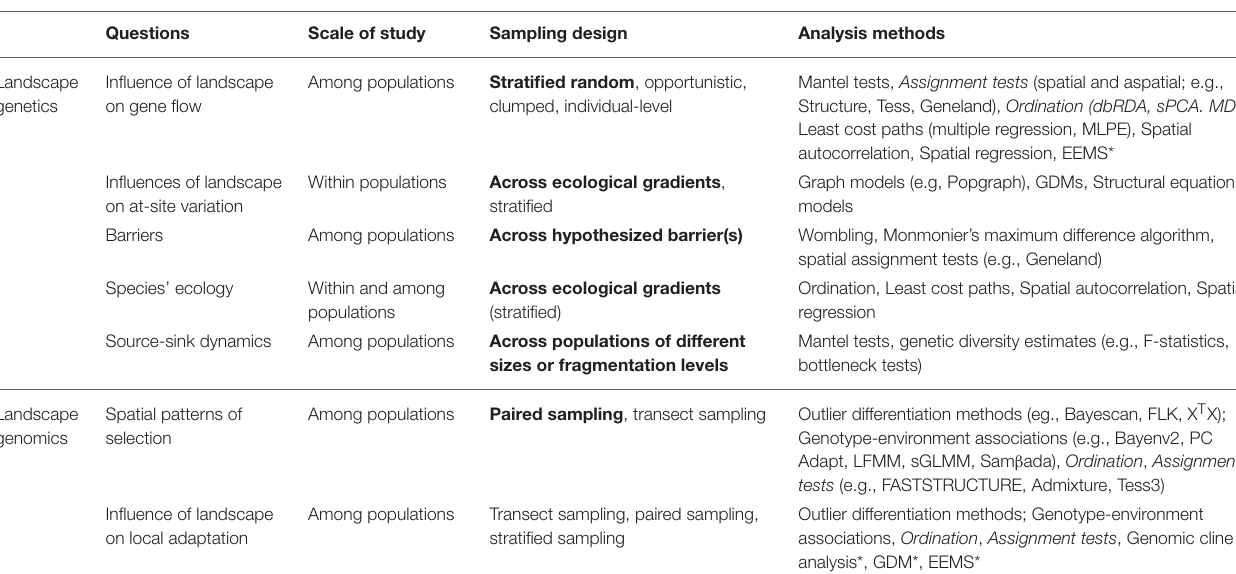
TABLE 1 | General differences between landscape genetics and landscape genomics